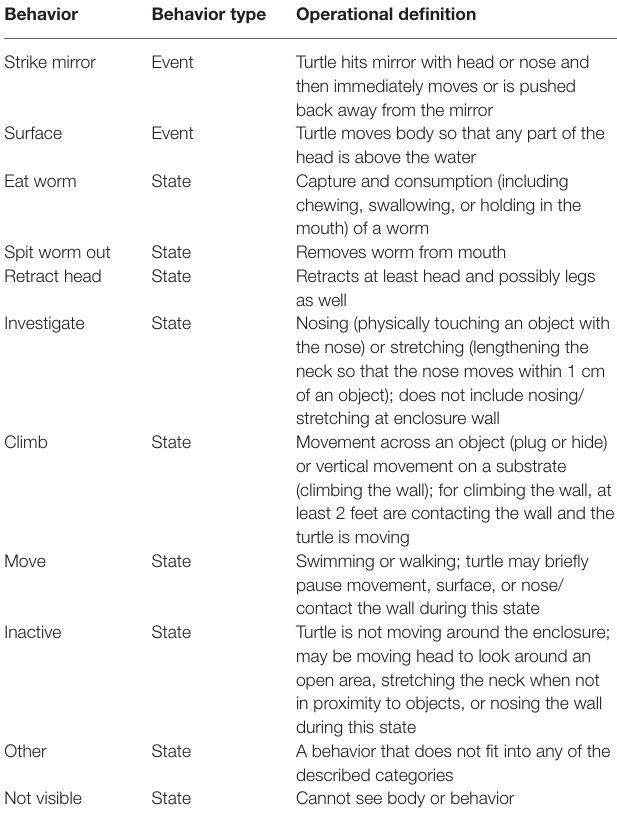
TABLE 1 | Ethogram for behavioral data collection in modified open field